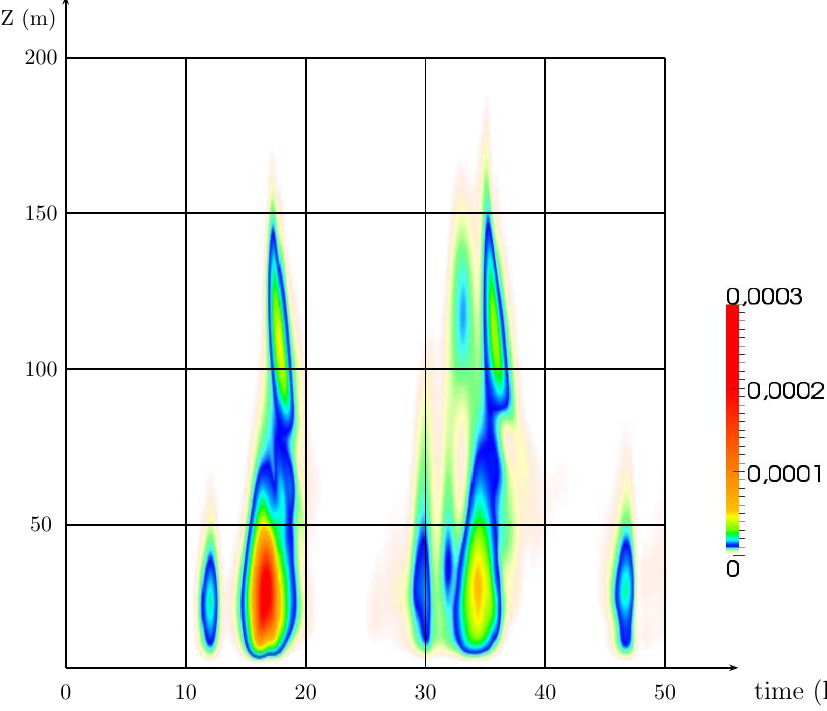
Fig. 10. Second h w 2 i moment of the vertical velocity (m 2 s − 2